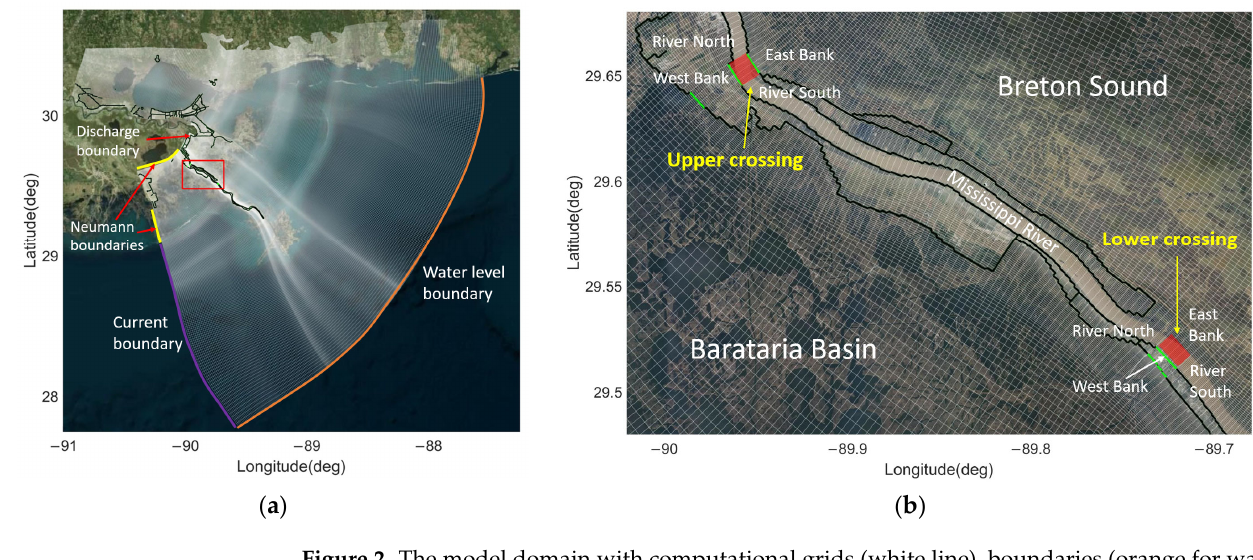
Figure 2. The model domain with computational grids (white line), boundaries (orange for water level, purple for current and yellow for Neumann) and the MR&T levee system (black line). Green lines denote the levee removal parts; filled red rectangles denote “control box” for flux analysis. ( a ) Entire model domain. ( b ) Local enlarged model domain.